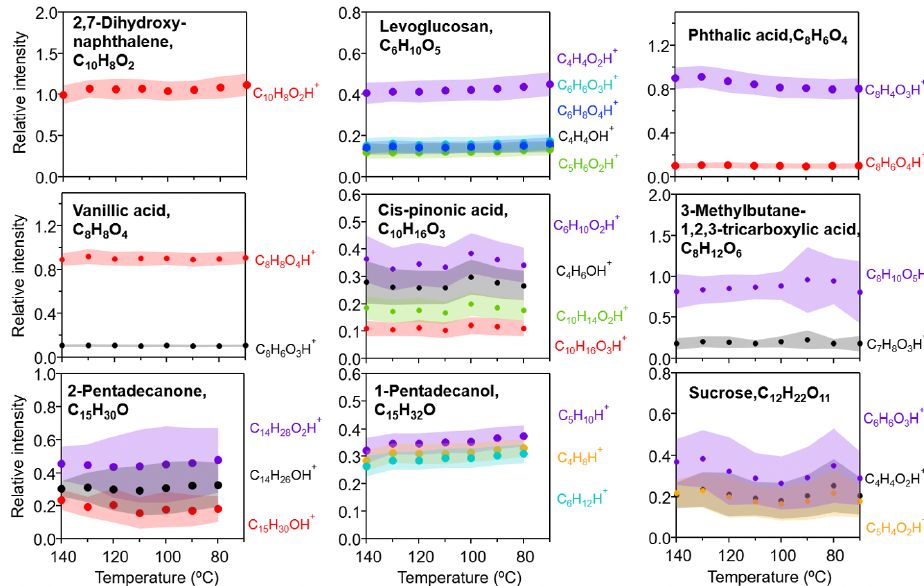
Figure 2. Ratios of CHARON–PTR-ToF-MS signals (ncps) to CPC measurements (ppb) of all detected ions (including both parents and fragments) for a given pure organic standard tested under different desorption temperatures (70–140 ◦ C), normalized to the corresponding ratios obtained at 140 ◦ C. Ions with relative intensities less than 10% are excluded. Red markers represent the parent peaks. Colored shades represent the relative standard deviations at different temperatures (exact values are given in Table